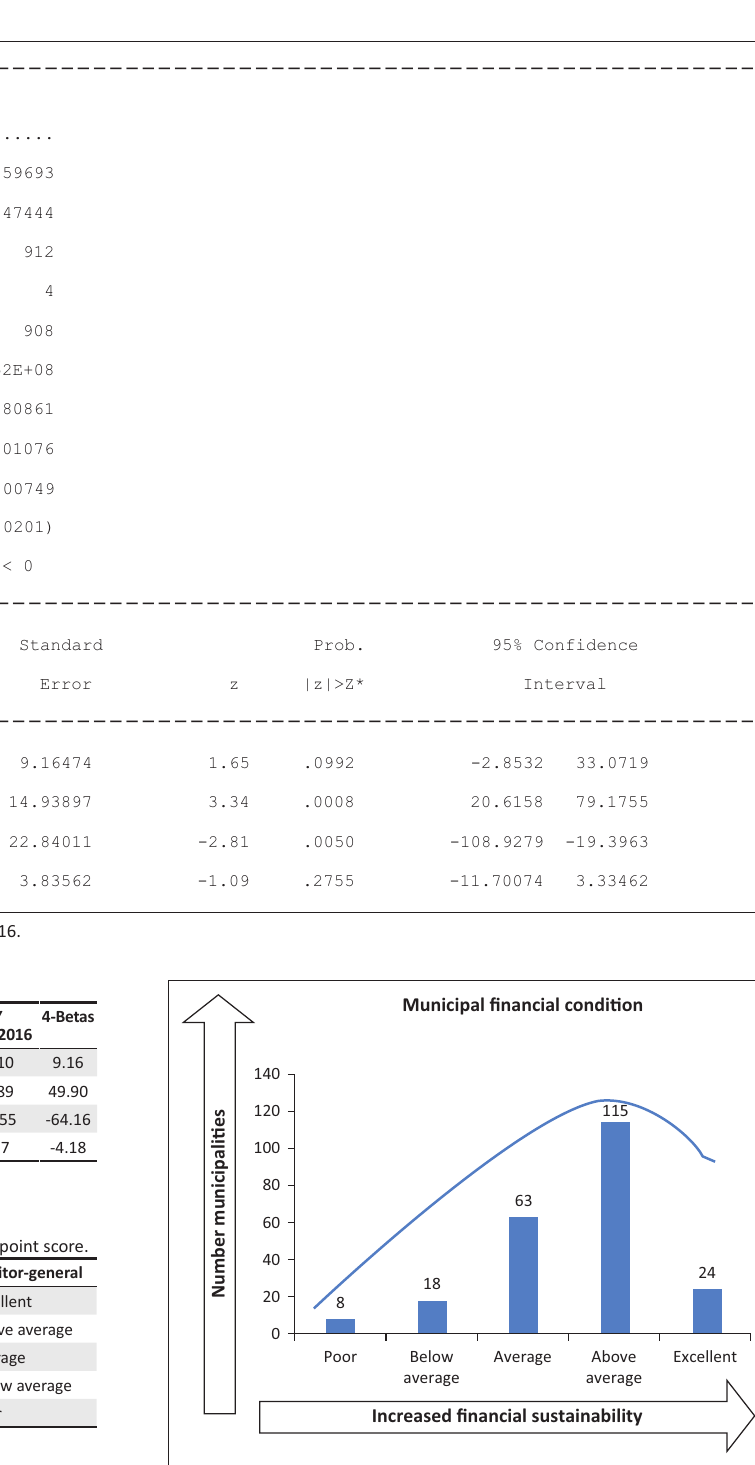
FIGURE 4: Financial condition by rank.